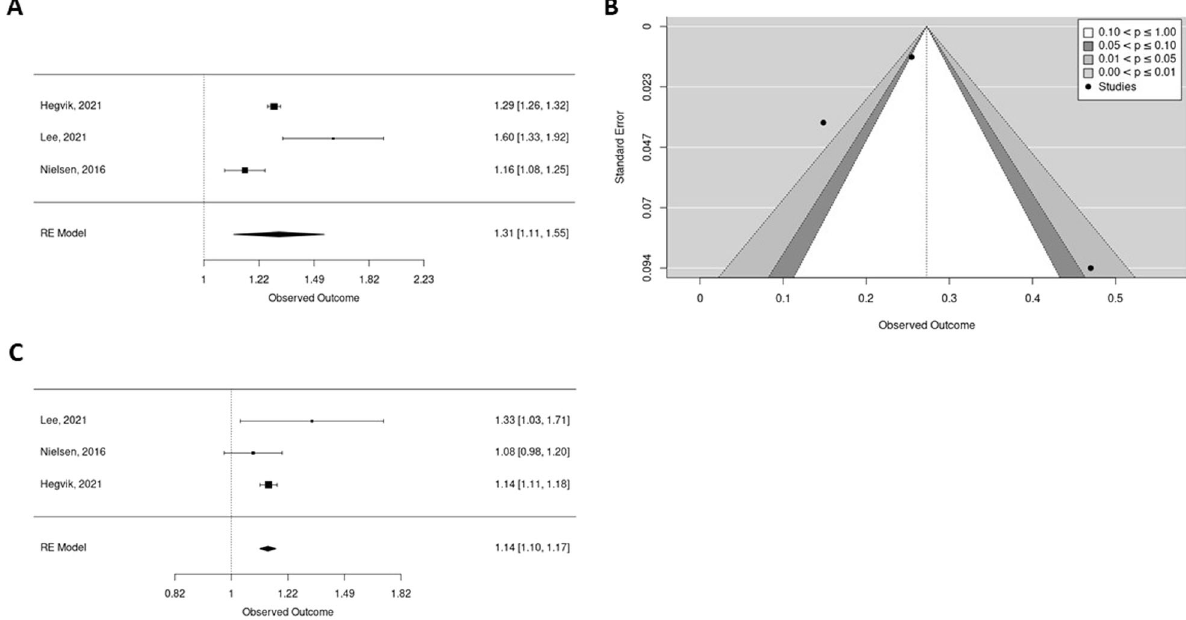
Fig. 3 Forest plot and contour enhanced funnel plot showing the meta-analysis results of the association between ADHD in parents and ASD in the offspring (adjusted). A Mothers, B Fathers. Each square represents individual study effect. Its size represents the study weight in the overall analysis. The black lines on either side of the squares represent the con fi dence intervals. The diamond at the bottom represents the summary effect with the outer edges representing the con fi dence intervals. Square or diamond on the right of the central bar (i.e., superior to 1) represents a positive association between paternal AID and ASD in the offspring. To be signi fi cant, the con fi dence interval lines must not cross 1. C Contour enhanced funnel plot for mothers ’ analysis. Areas represent studies with p -values larger than 0.10 (white), smaller than 0.05 (light gray), smaller than 0.01 (dark gray), and smaller than 0.001 (light gray outside large triangle).